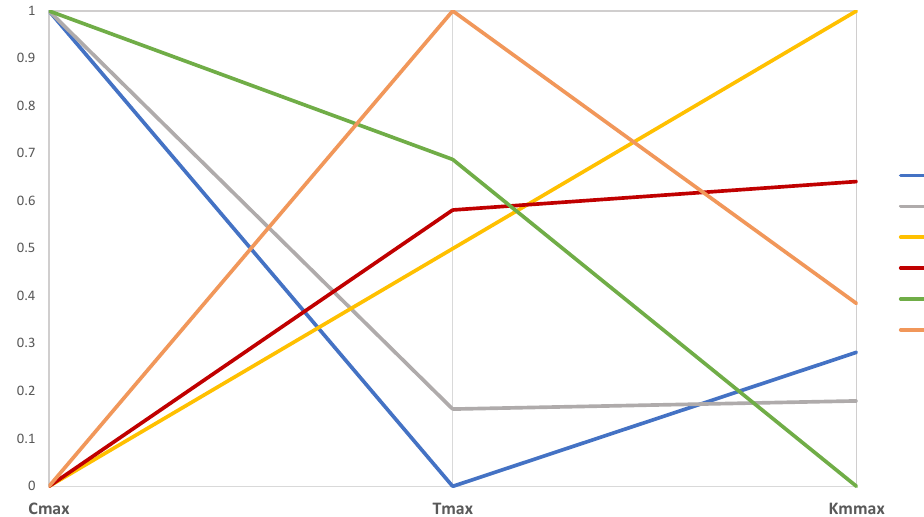
Figure 7. Path value graph for six selected non-dominated